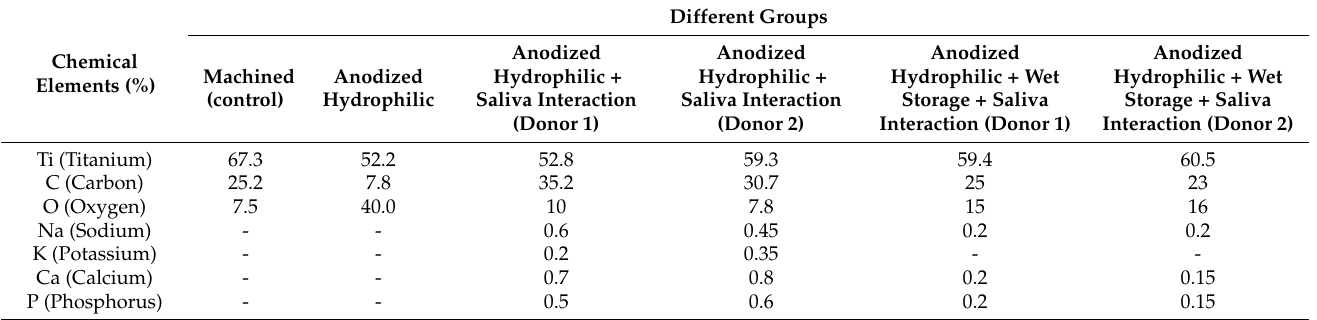
Figure 3. Superficial morphology acquired by SEM and by AFM of nanotubular surfaces before (( a )—SEM, scale bar—4 µ m and ( c )—AFM) and after (( b )—SEM, scale bar—5 µ m and ( d )—AFM) saliva interaction for 10 min. Small impurities (red arrows) can be observed after saliva exposition ( c ); however, no significant morphological alteration on the nanotubular surface could be detected. Table 3. Chemical elements identified by EDS before/after saliva interaction on anodized surfaces.